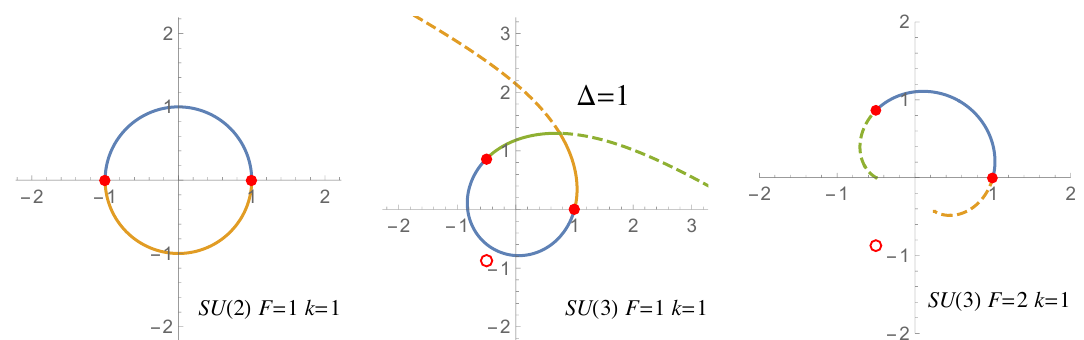
Figure 2: Symmetry preserving k -walls in massive SU ( N ) SQCD with F < N flavors for N = 2,3. Each figure refers to fixed values of N , F and soliton sector k . We draw the N vacua (red dots and circles) on the (cid:101) M -plane, as well as the pre-image of a straight line in the W -plane connecting W −∞ to W + ∞ . The pre-image consists of N curves, drawn in different colors. Paths connecting the vacua and thus corresponding to domain walls are solid lines, while the rest of the pre-image is dashed. If a path involves a jump from one sheet to another (namely, from one portion of the pre-image to another), we indicate the value of ∆